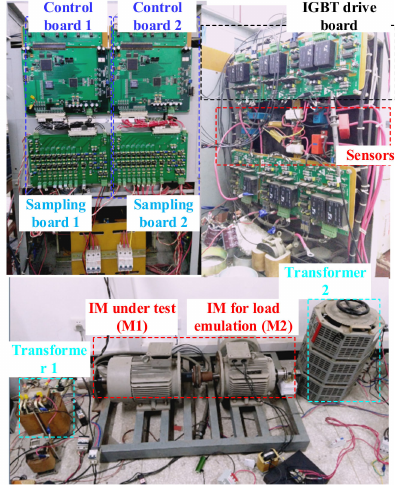
Figure 26. Experimental platform. The PI control without decoupling and feed-forward decoupling control are shown in Figures 27 and 28, respectively. Compared with the traditional PI control, when the q -axis current step changes, the amplitude of the current drop in the d -axis becomes smaller, indicating that the coupling degree is reduced to some extent for the feed-forward decoupling control.